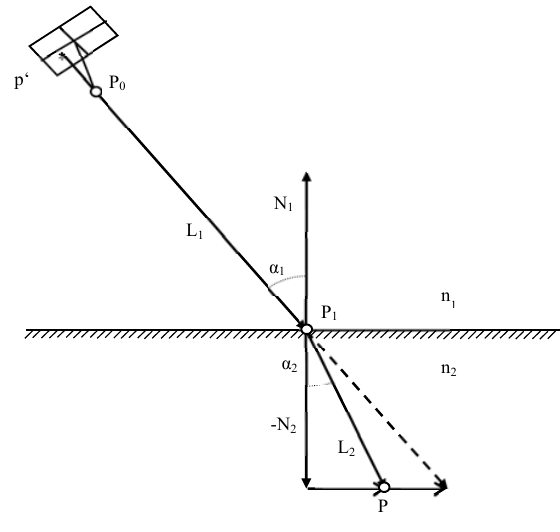
Figure 5: Refraction in two-media